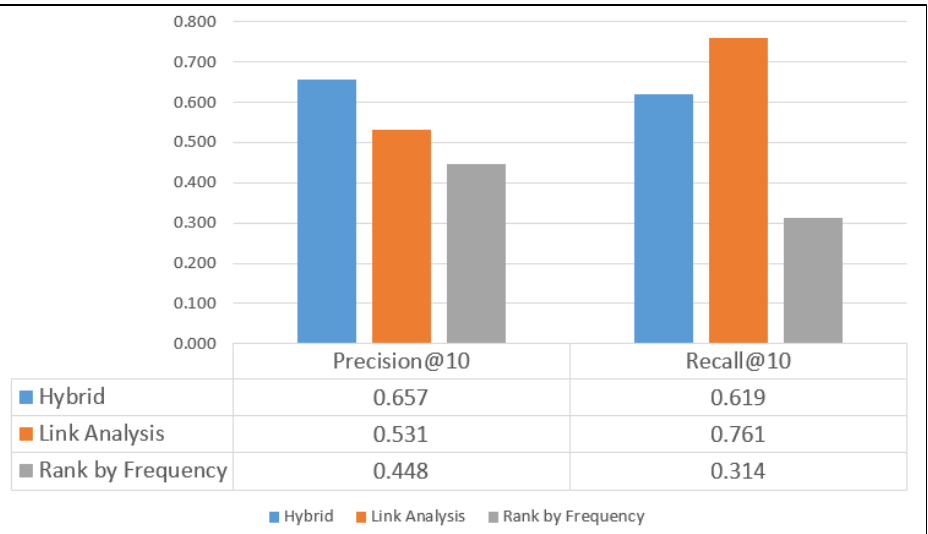
Sensors 2020 , 20 , x FOR PEER REVIEW Figure 11. Results for the Gowalla dataset. Figure 11. Results for the Gowalla dataset.